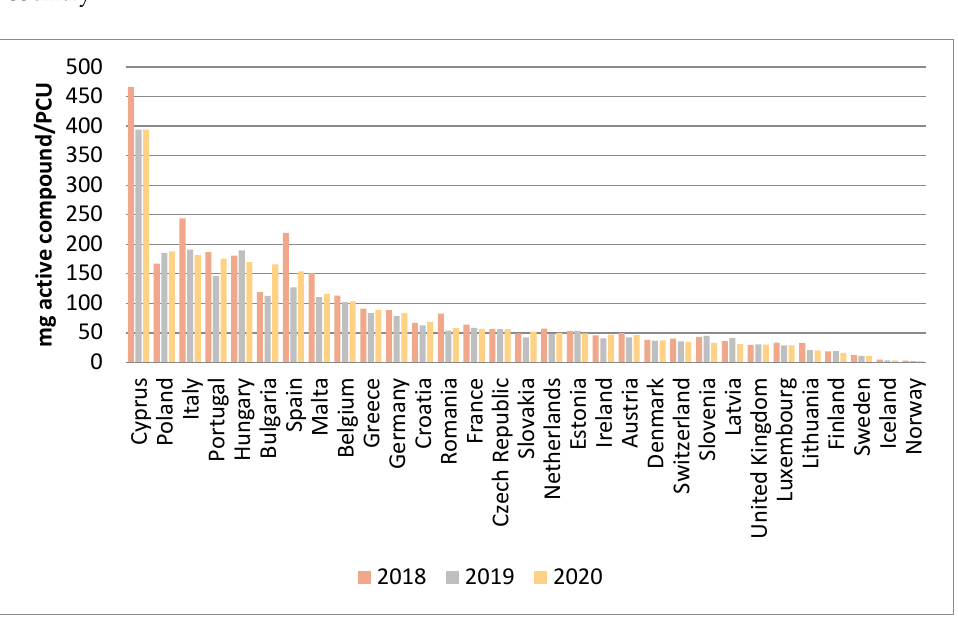
Figure 1. Antimicrobial use in animals in 31 European countries expressed in mg active component/ PCU between 2018 and 2020 (based on eleventh ESVAC report, 2021).